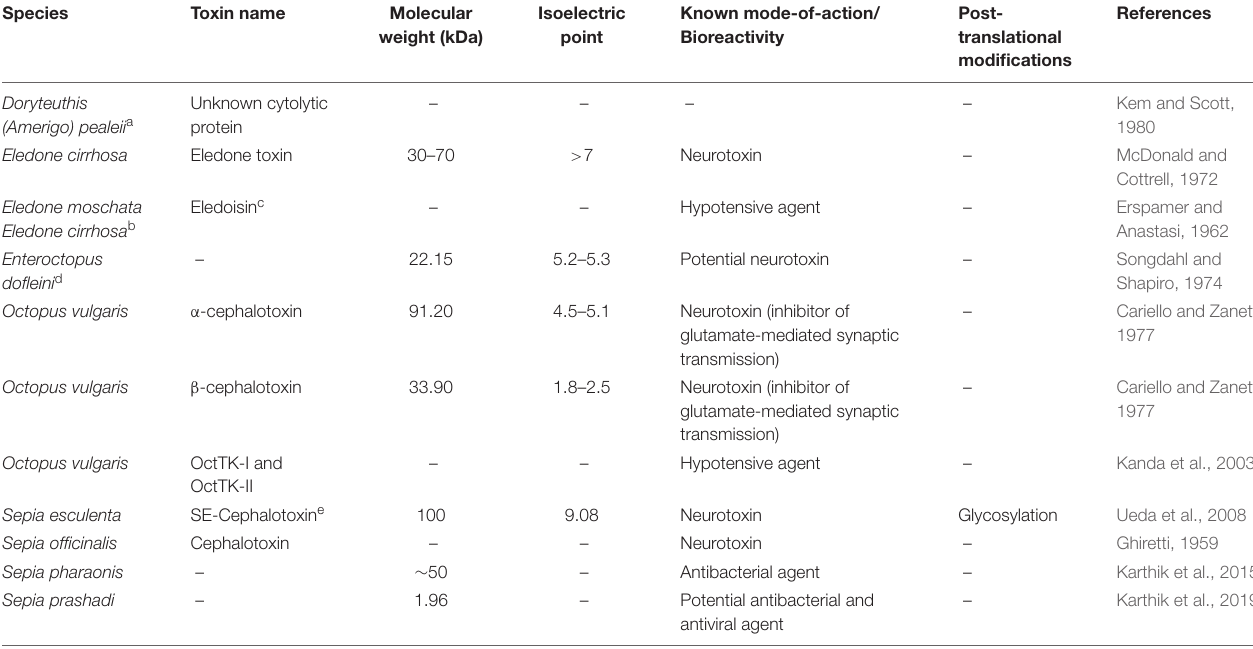
TABLE 1 | A comparative overview cephalotoxins and other major proteinaceous or peptidic neurotoxins considered specific of cephalopods.